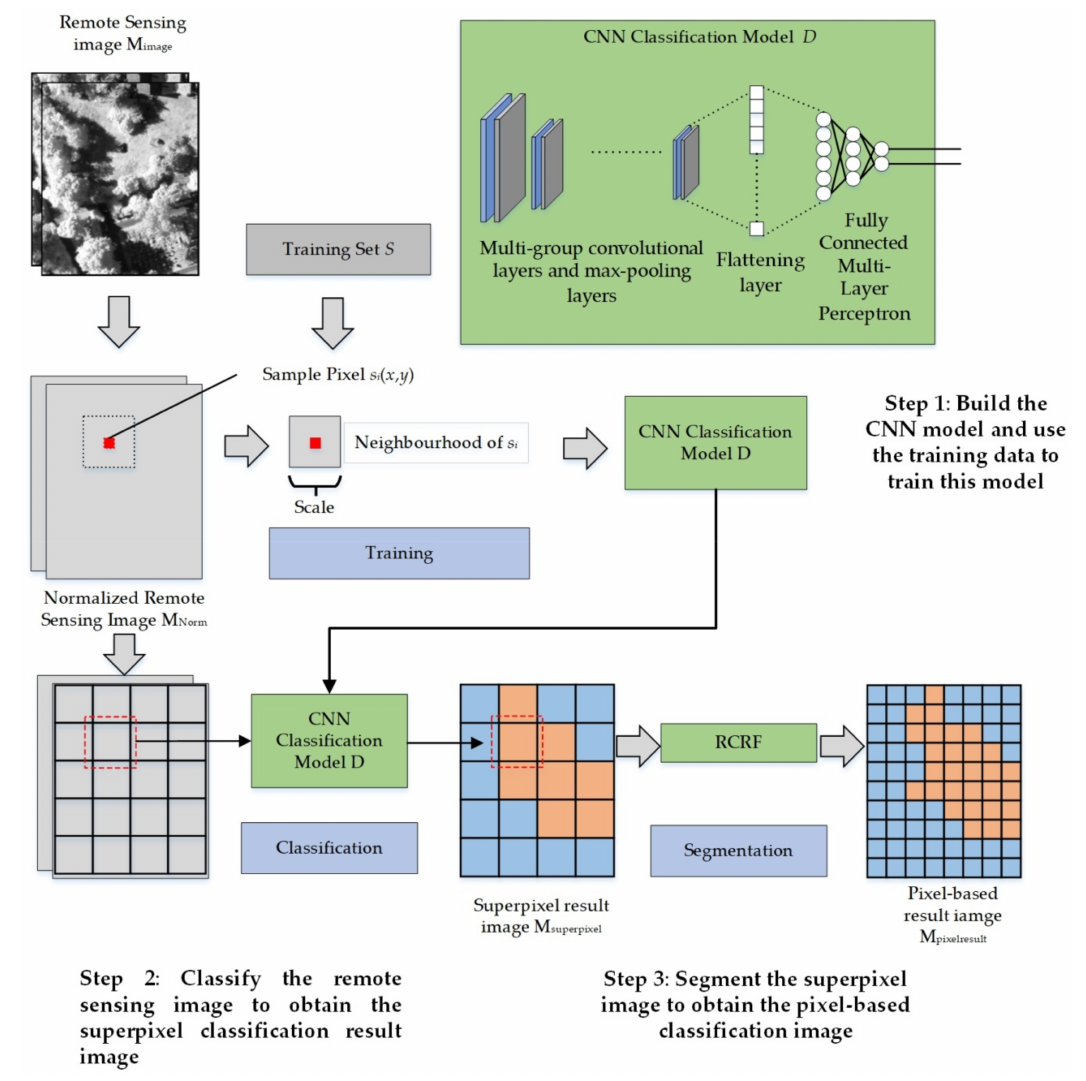
Figure 2. Basic process of the convolutional neural network-restricted conditional random field algorithm